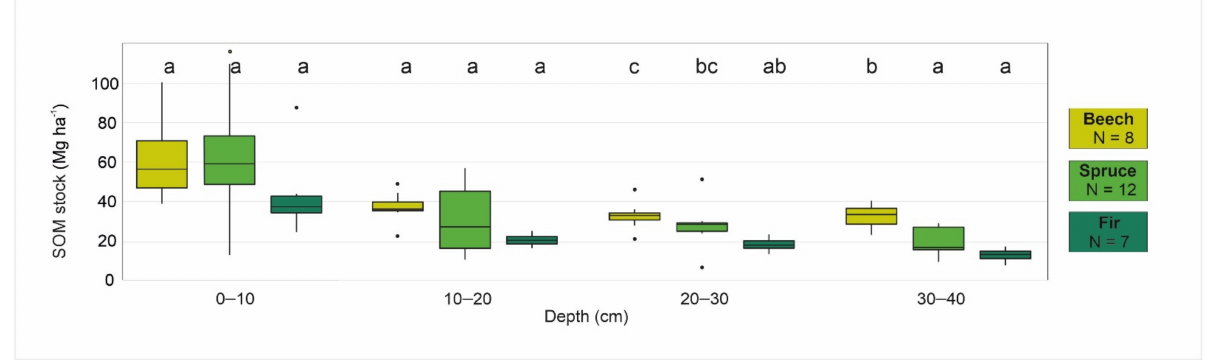
Figure 4. Distribution of soil organic matter stock at the studied soil depths for the analyzed tree stands, expressed using boxplots (boxplots—see explanation in Figure